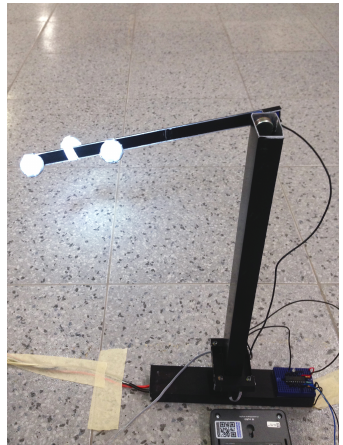
Figure A2. Setup of the reflective markers.